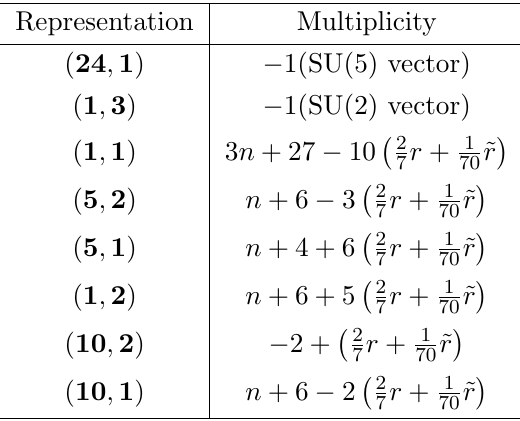
Table 4 . The spectrum for the con(cid:12)guration